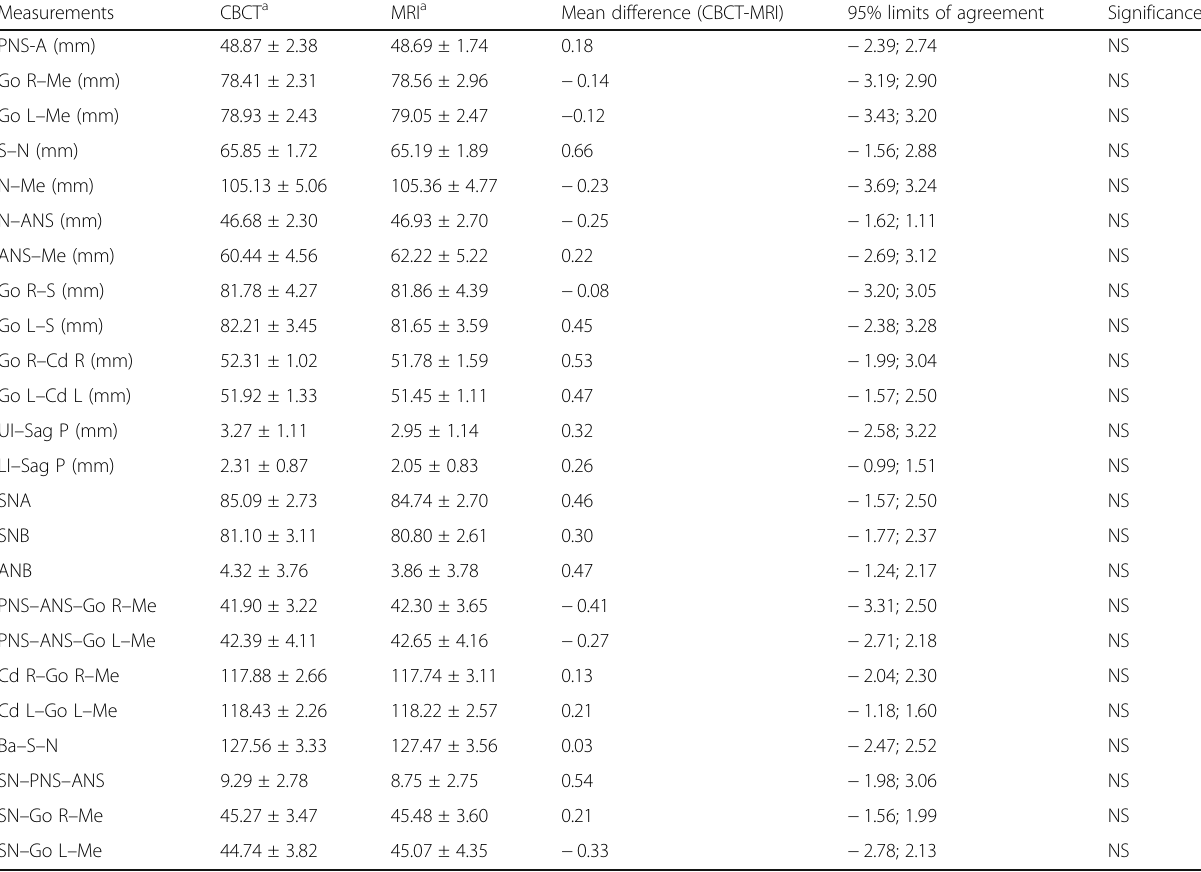
Table 3 Three dimensional cephalometric measurements from CBCT and MRI